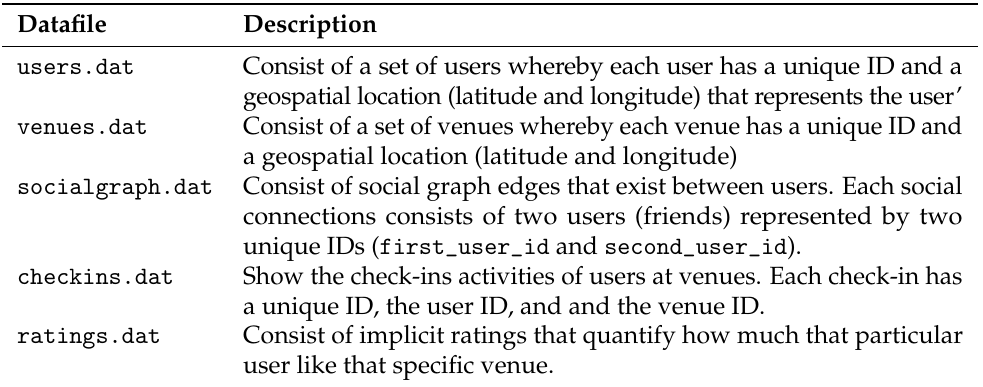
Table 2. The content and the usage of the data